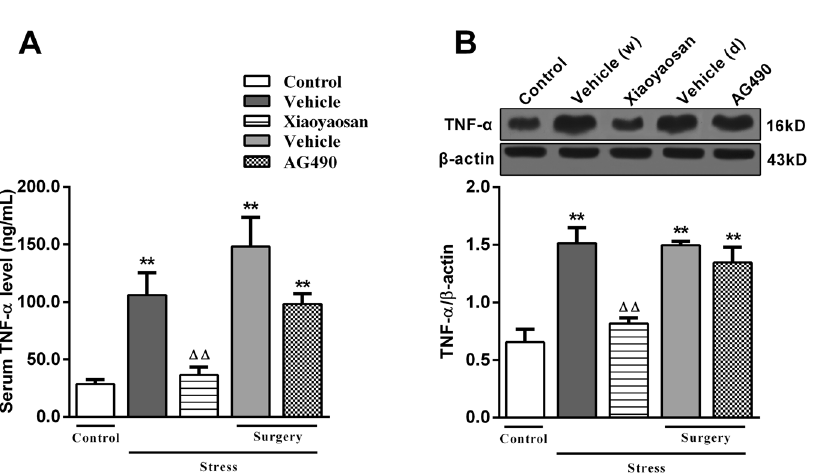
Figure 4. Effects of Xiaoyaosan on the serum TNF- α levels and hippocampal levels of the TNF- α protein. ( A ) Serum TNF- α levels. ( B ) Expression of the TNF- α protein in the rat hippocampus. Values are presented as the means ± SEM from 10 rats in each group for the determination of the serum TNF- α levels and 3–4 rats for the expression of the TNF- α protein in the hippocampus. ** P < 0.01 versus the control group. ΔΔ P < 0.01 versus the vehicle (distilled water)